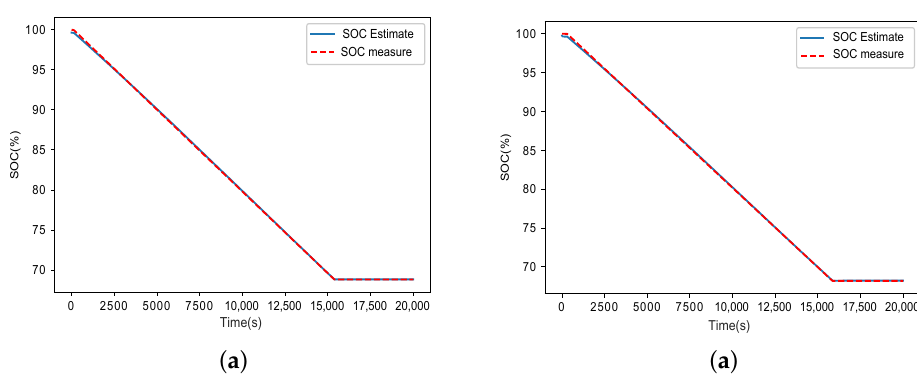
Figure 12. SOC estimation for: ( a ) − 10 ◦ C and ( b ) 50 ◦ C based on low current OCV test.